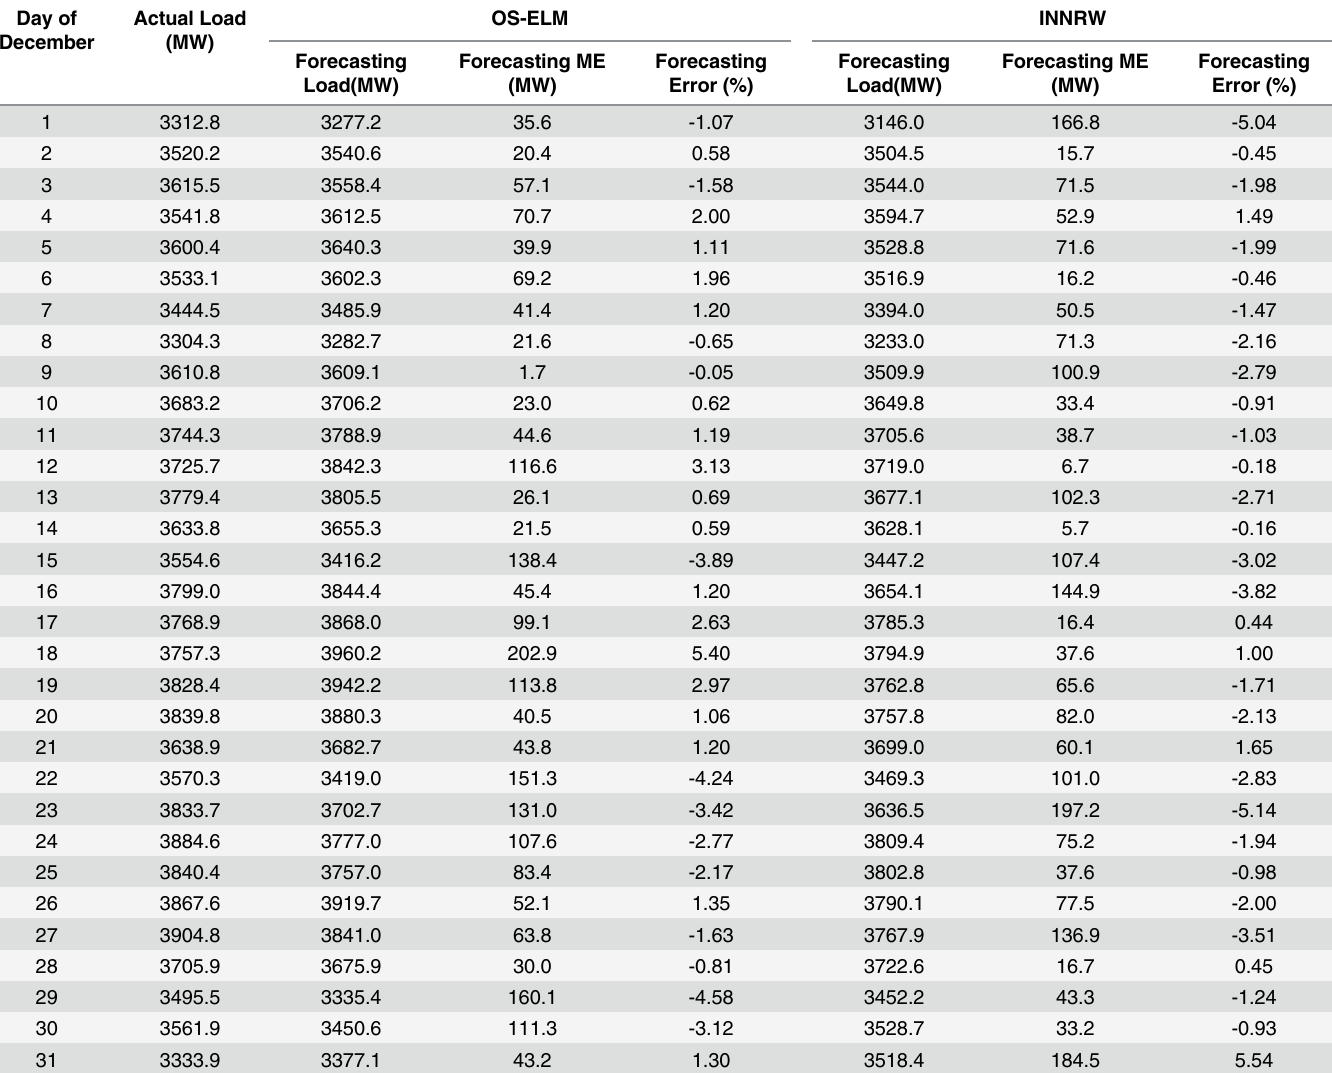
Table 3. Forecasting